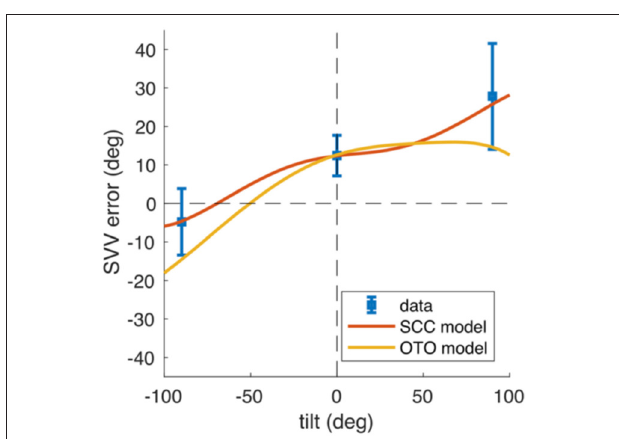
FIGURE 8 | Mathematical model data predicting and simulating tilts of subjective visual vertical (SVV). SVV data from Merfeld et al. (99) obtained in patients with unilateral vestibular nerve section (blue, error bars denote SD) and model simulations of the SVV adjustments (red and yellow) in upright and tilted (right ear down, left ear down) body positions. The OTO model (yellow) assumes unequal distribution of hair cells with opposite tuning on the utricular macula (Ewald’s law for otolith organs). The SCC model (red) assumes that the afferent input of vertical semicircular canals is processed centrally by the gravity estimation mechanism. After a lesion, the semicircular canal bias causes a perceptual error of gravity direction that becomes visible as SVV tilt [From Glasauer et al.